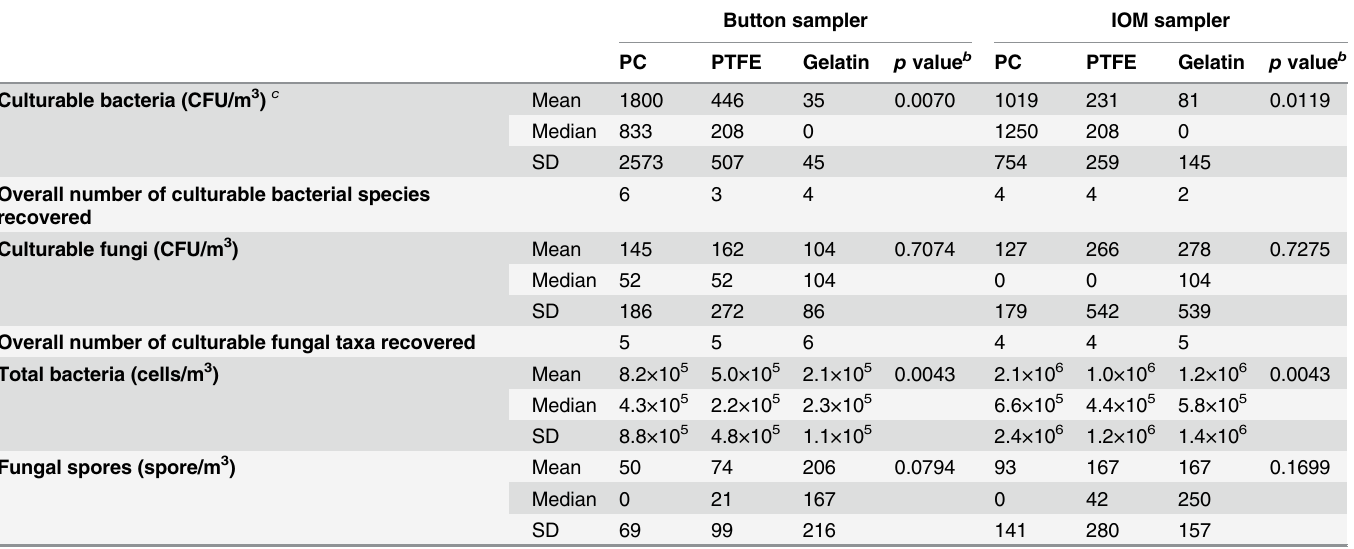
Table 2. Relative efficiency comparison of filters. a